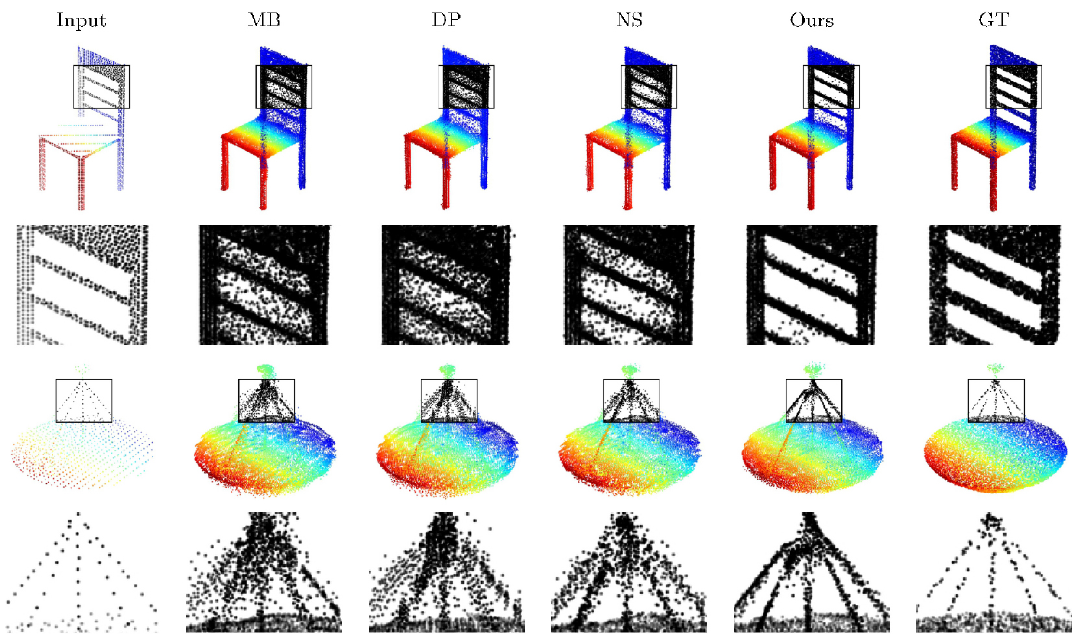
Fig. 10 Example shape completion results using the ShapeNet dataset using different feature expansion networks.